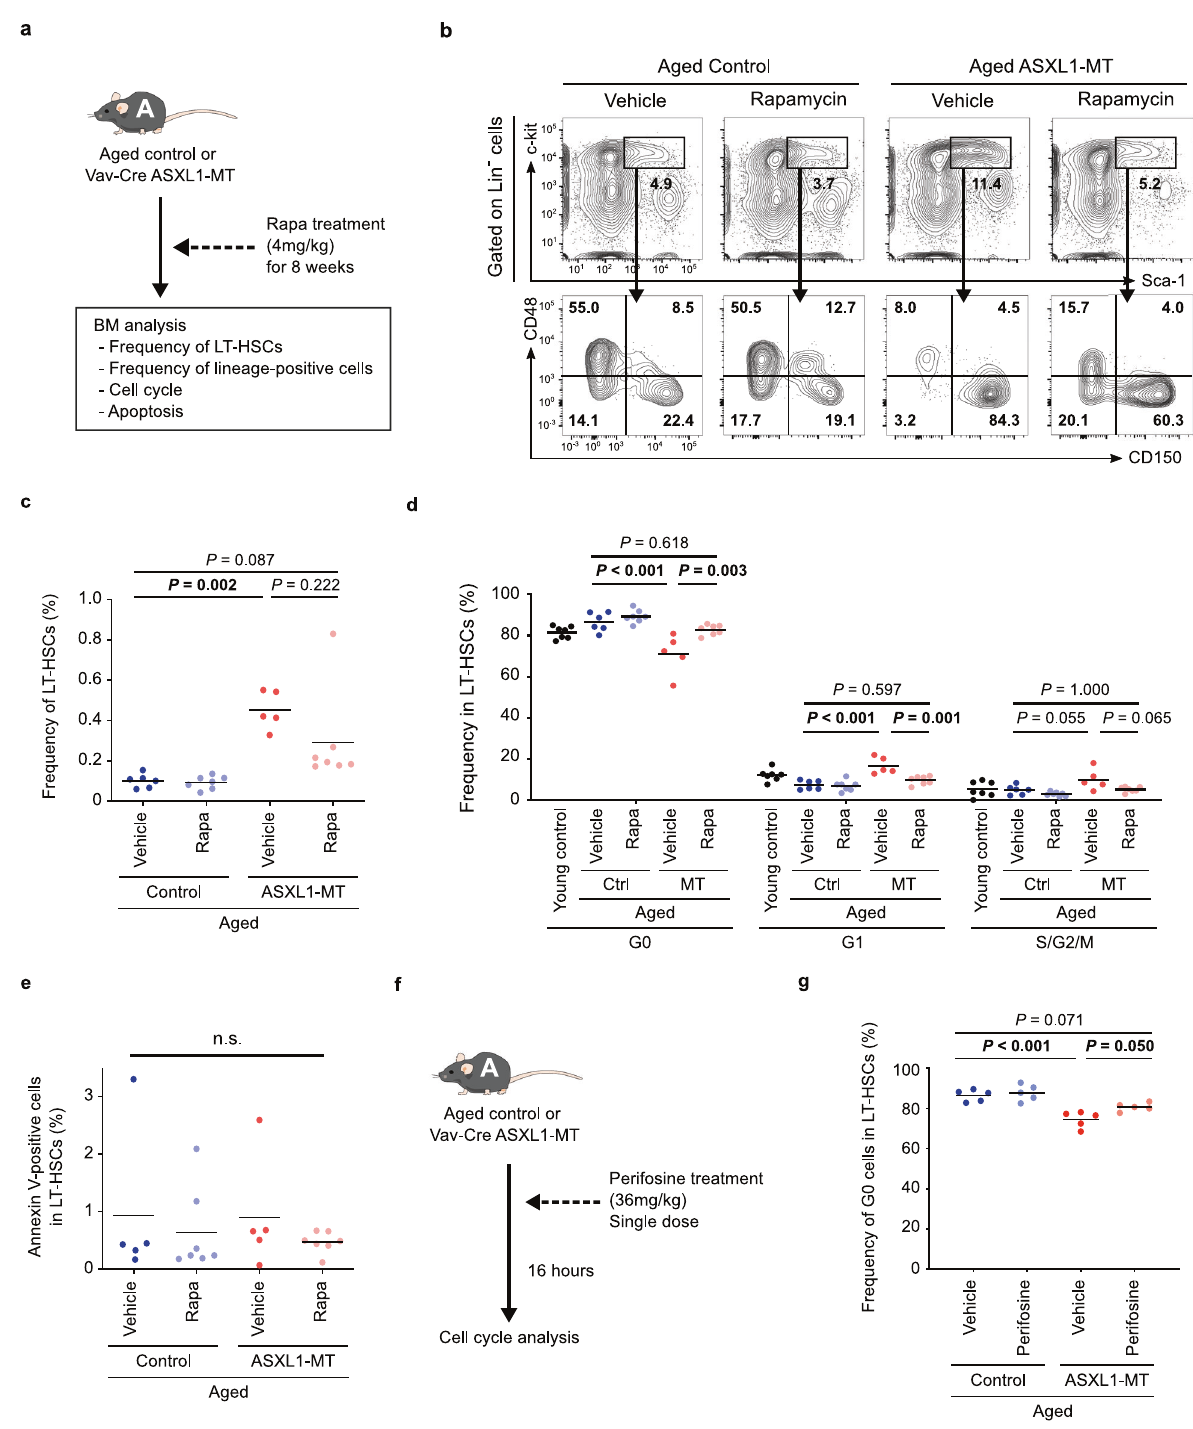
Fig. 5 Inhibition of Akt/mTOR pathway ameliorates ASXL1-MT-induced aberrant proliferation of pLT-HSCs. a The experimental design for treatment with an mTOR inhibitor rapamycin in aged mice. Aged Vav-Cre ASXL1-MT KI mice and age-matched control mice were treated with rapamycin intraperitoneally (4 mg/kg/day) every other day for 8 weeks. At the end of administrations, end-point analyses of bone marrow cells were conducted. b , c The frequency of LT-HSCs in bone marrow MNCs ( n = 6 (Control-Vehicle), 7 (Control-Rapamycin), 5 (ASXL1-MT-Vehicle), and 7 (ASXL1-MT- Rapamycin)). Representative FACS plot ( b ) and summarized data ( c ) are shown. d Cell cycle analysis with Ki-67/DAPI staining of LT-HSCs ( n = 7 (Young control), 6 (Control-Vehicle), 7 (Control-Rapamycin), 5 (ASXL1-MT-Vehicle), and 7 (ASXL1-MT-Rapamycin)). e Apoptosis analyses of LT-HSCs ( n = 5 (Control-Vehicle), 7 (Control-Rapamycin), 5 (ASXL1-MT-Vehicle), and 7 (ASXL1-MT-Rapamycin)). f The experimental design for treatment with an Akt inhibitor perifosine in aged mice. Aged Vav-Cre ASXL1-MT KI mice and age-matched control mice were treated with a single oral dose (36 mg/kg) of perifosine ( n = 5). g 16 h after administration, cell cycle analyses with Ki-67/DAPI staining of LT-HSCs were performed. Statistical signi fi cances are assessed by one-way ANOVA with Tukey – Kramer ’ s post-hoc test. * P ≤ 0.05, ** P ≤ 0.01, *** P ≤